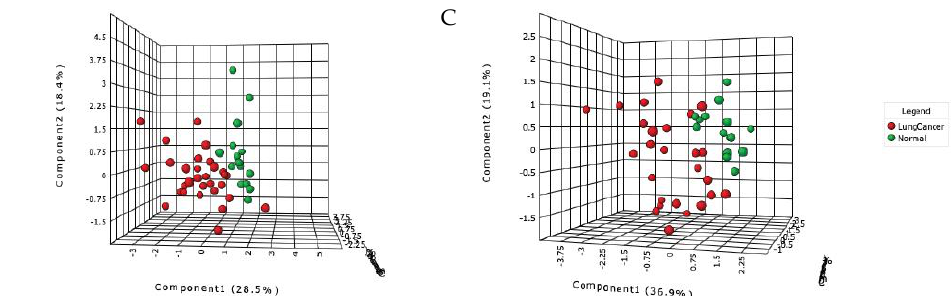
Figure 2. Cluster Analysis. Hierarchical cluster analysis and heat map of correlation between the metabolites using training dataset ( A ); Partial Least-Squares Discriminant Analysis: training dataset ( B ); and test dataset ( C ).